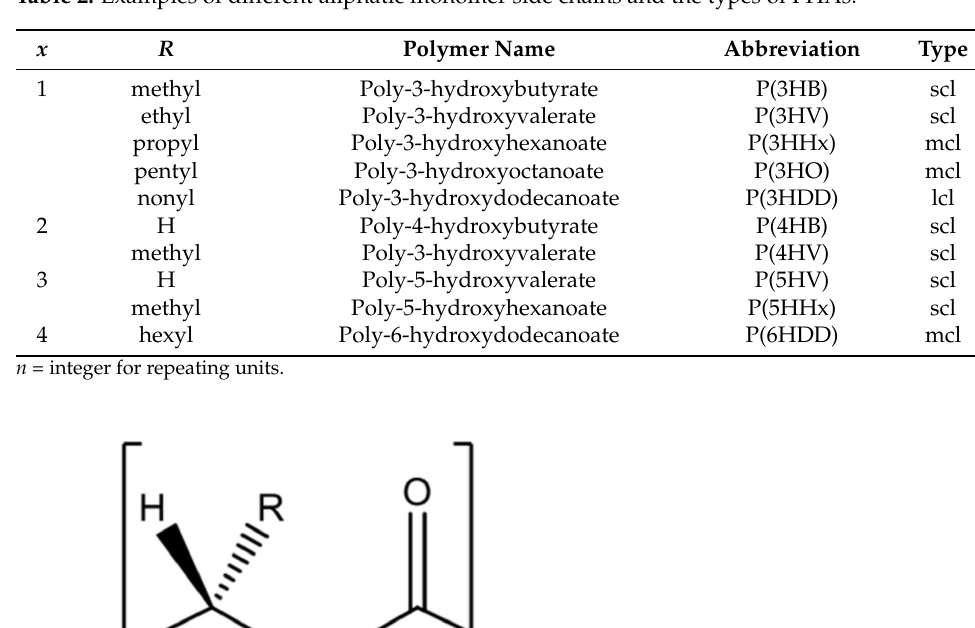
Table 2. Examples of different aliphatic monomer side chains and the types of PHAs.